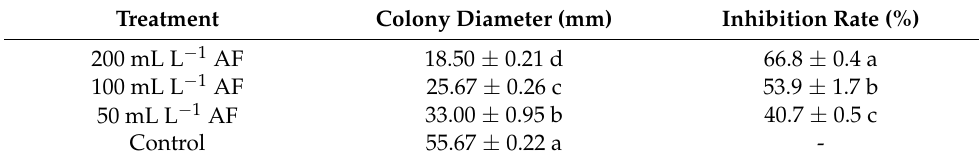
Table 1. Inhibitory activity of aseptic filtrate against Alternaria alternata . Treatment